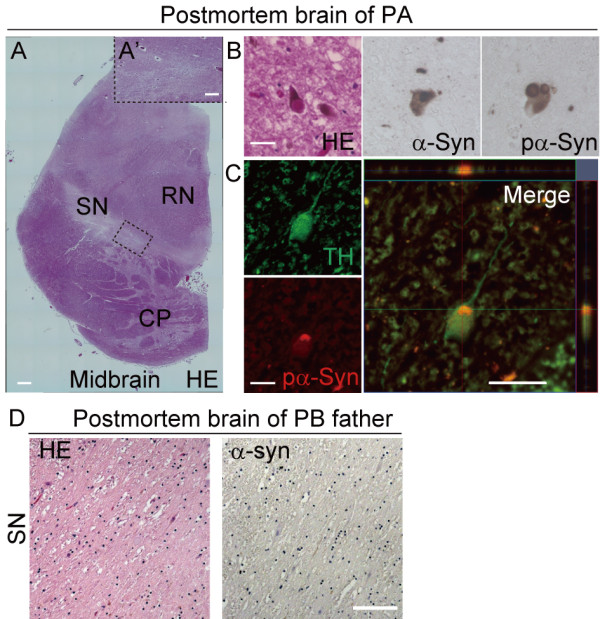
Accumulation of LBs in the postmortem brain of patient PA. (A–C) Immunohistochemical staining of postmortem brain tissue from patient PA. (A) Low magnification image of a midbrain section stained with hematoxylin and eosin (H&E). (A’) High magnification image of the boxed area. Melanin levels were reduced in most of the substantia nigra (SN). (B) (Left) High magnification image of a midbrain section stained with H&E showing the presence of Lewy bodies (LBs) in the SN. (Middle and Right) α-synuclein-positive and pα-synuclein-positive cells in the SN. (C) Confocal microscopy image of a TH (green) and pα-synuclein (red) double-positive SN neuron and a projected merged image: pα-synuclein accumulated in the TH-positive neuron. (D) Melanin levels were reduced in most of the SN. No LBs or α-synuclein-positive neurons were observed in postmortem brain tissue from the father of patient PB. Scale bars: A, 1000 μm; A’, 350 μm; B, C, 50 μm; D, 100 μm.